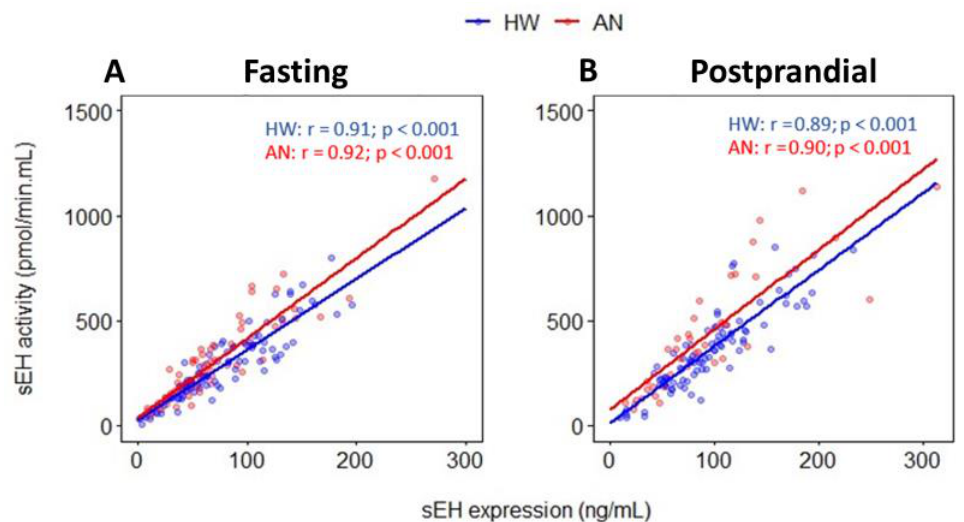
Figure 1. Pearson’s correlations between soluble epoxide hydrolase (sEH) expression and sEH activity in healthy women (blue) and women with AN (red) at ( A ) fasting and ( B ) postprandial timepoints. Colored dots and solid lines represent individual data points and slopes of the examined relationships, respectively. r and p indicate Pearson’s correlation coefficient and p value, respectively. HW: healthy women; AN: anorexia nervosa.